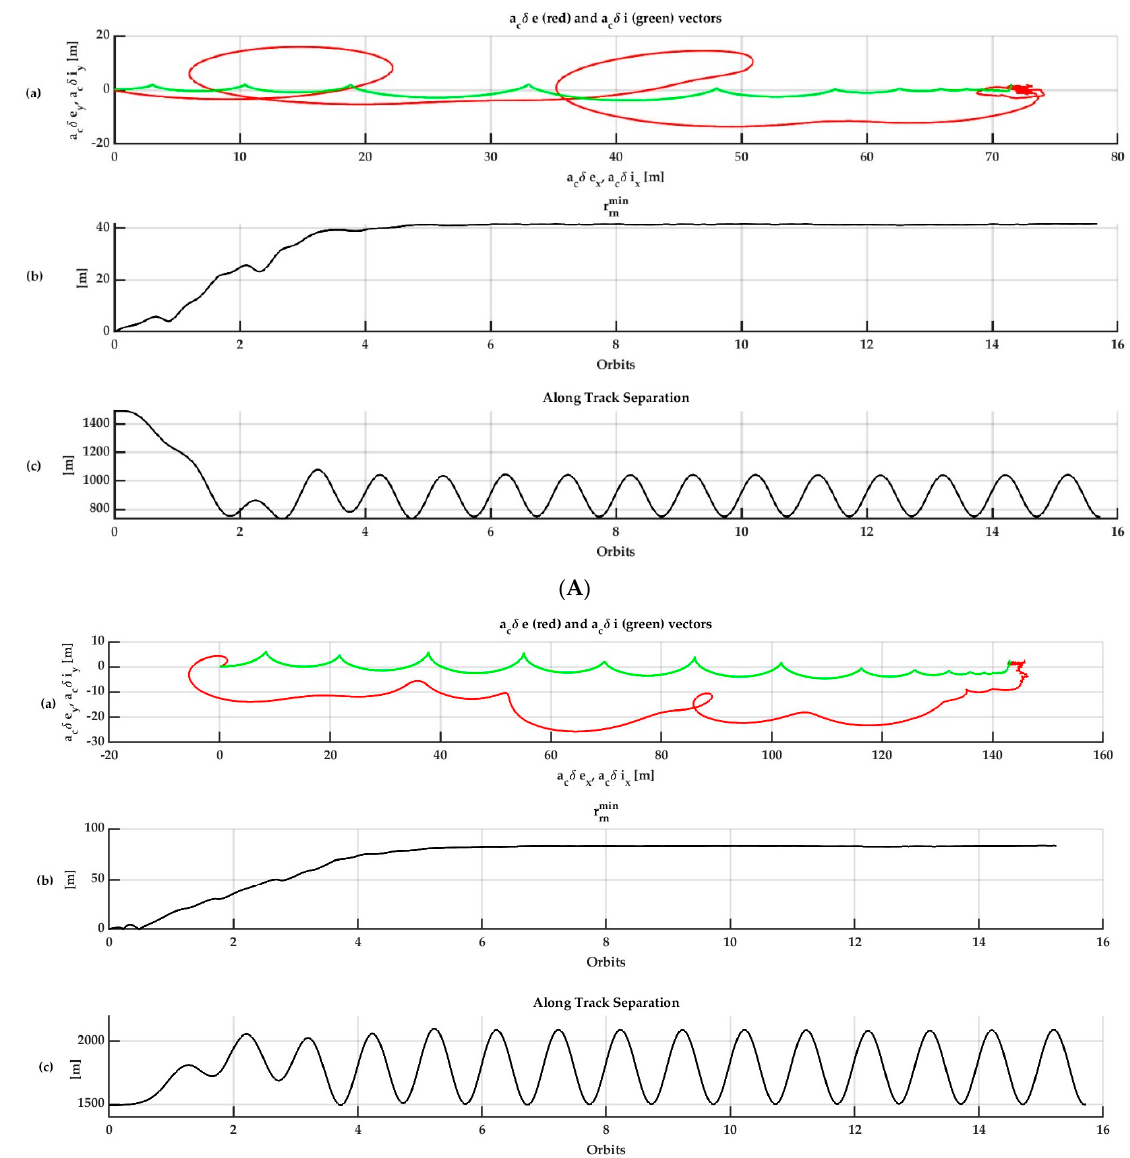
Figure 7. ( A ) Simulation of a Robust Multibaseline AT-InSAR formation for follower 1. ( a ) Shows the components of δ e and δ i , ( b ) shows the δ r min rn and ( c ) shows the along track separation between follower 1 and the chief. ( B ) Simulation of a Robust Multibaseline AT-InSAR formation for follower 2. ( a ) Shows the components of δ e and δ i , ( b ) shows the δ r min rn and ( c ) shows the along track separation between follower 2 and the